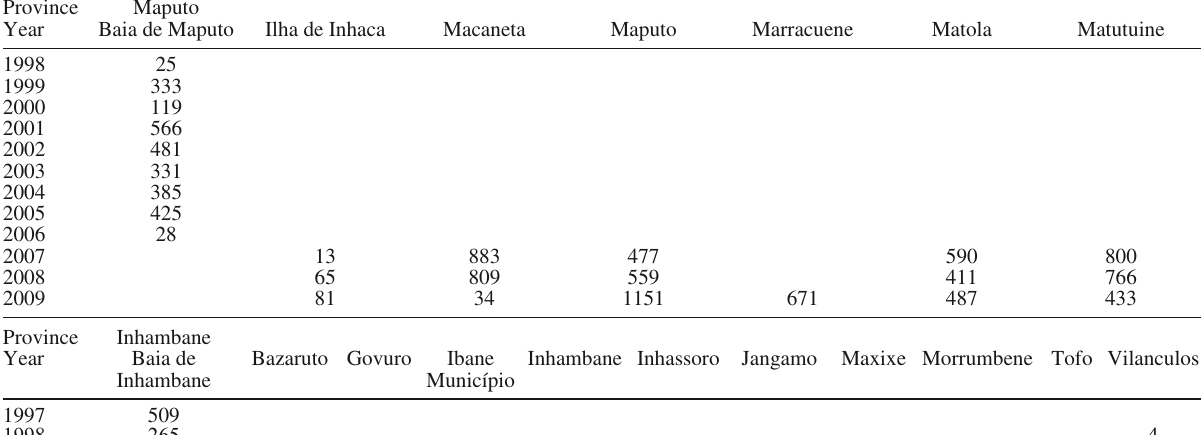
Table 2. – Number of site-day observations collected for each year and landing site in the provinces of Maputo, Inhambane, Nampula and